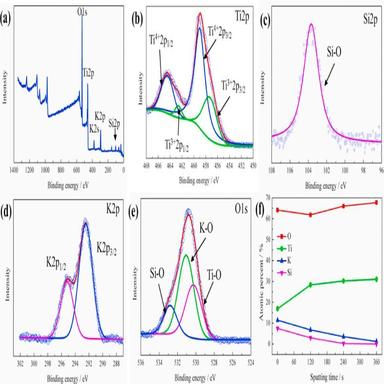
(a) XPS full spectrum and high-resolution XPS spectra of (b) Ti2p, (c) Si2p, (d) K2p, (e) O1s, and (f) atomic percent-depth profile of Ti, Si, K, and O in Ti4O7 coated Ti electrode at different Ar ion sputtering time.